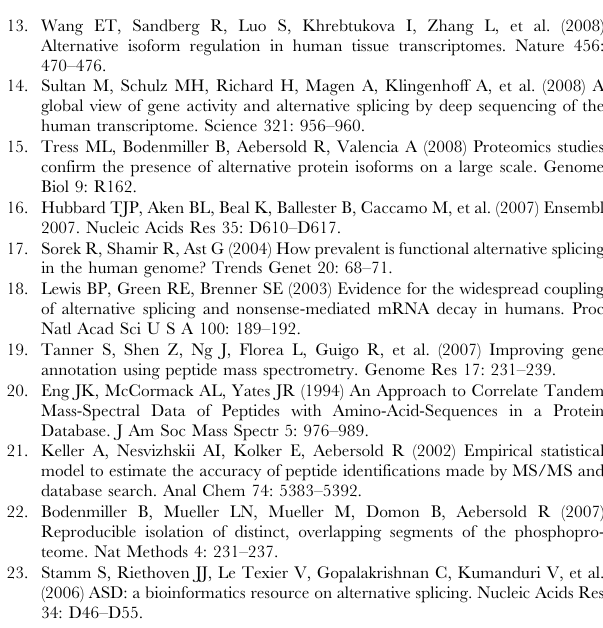
Table S4 KEGG annotations for all the genes found in IPI. In total, 78 pathways were found. These pathways are sorted by impact factor, a probabilistic term which is calculated from the number of genes in the input file, the size of the reference chip (U133 plus2.0), the number of input genes that are on a given pathway and the number of the pathway genes represented on the reference